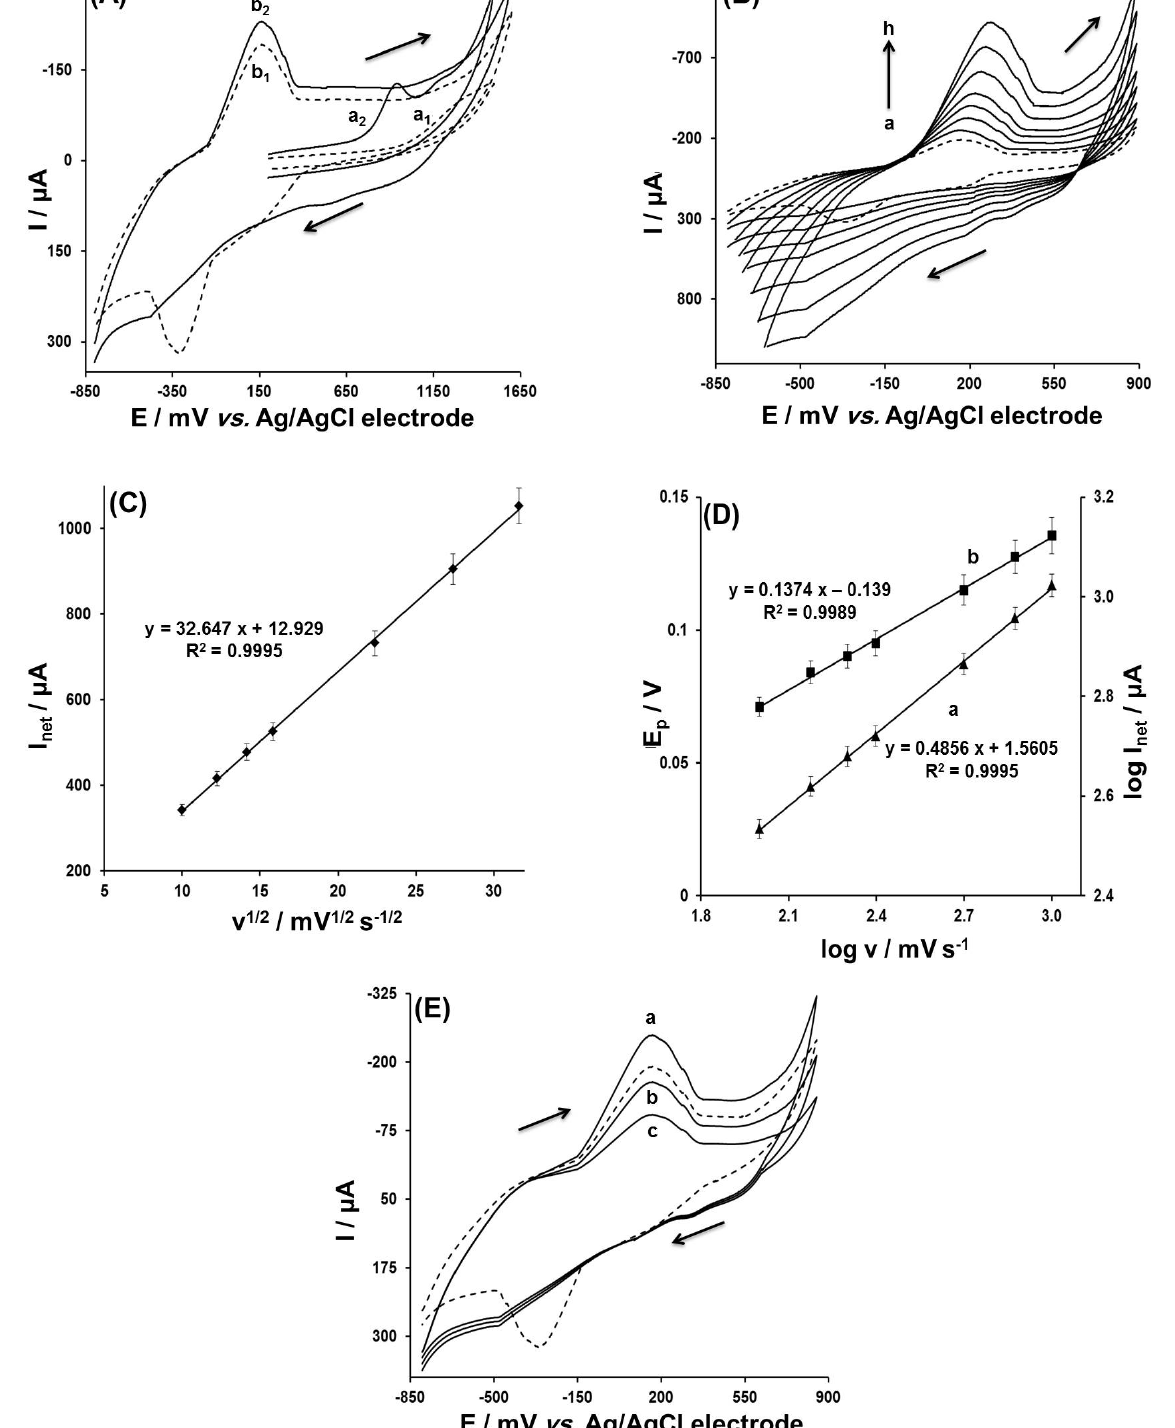
Figure 6. ( A ) Cyclic voltammograms of blank solution using ( a1 ) CPE and ( b1 ) Cu 2 ONPs-C@G/PE, and in presence of 2 × 10 − 5 M MEB using ( a2 ) CPE and ( b2 ) Cu 2 ONPs-C@G/PE. ( B ) The recorded cyclic voltammogram using Cu 2 ONPs-C@G/PE ( a ) before and ( b – h ) after addition of 2 × 10 − 5 M MEB at different scan rate values in the range of 100–1000 mV/s. ( C ) Plot of peak current ( I net ) versus square root of scan rate ( ν 1/2 ). ( D ) Plot of logarithm scan rate ( log ν ) versus ( a ) logarithm peak current ( log I net ) and ( b ) peak potential ( E p ). ( E ) Successive cyclic voltammogram of 2 × 10 − 5 M MEB using Cu 2 ONPs-C@G/PE. All cyclic voltammograms where recorded under optimized instrumental and experimental condi- tions.